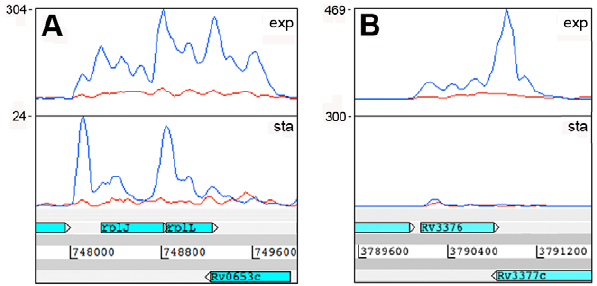
Figure 2. Antisense transcripts arising from 3’ UTRs. Examples of transcription profiles vizualised using the Artemis genome browser. Blue and red traces show transcription in the forward and reverse direction respectively. The x-axis records the position on the genome, and the y-axis records the number of reads mapped at that location; the maximum expression is shown on the y-axis. Examples illustrate 3’ UTR profiles that tail off into the adjacent gene (panel A) or rise to a peak in the overlap region (panel B). A. Rv0653c (a predicted transcriptional regulator) is covered by an antisense transcript extending from the 3’ end of the rplJ - rplL ribosomal protein operon in exponential phase, but not in stationary phase. B. The 3’ end of Rv3377c (a putative cyclase gene) is covered by an antisense transcript from the converging gene Rv3776. Again the antisense overlap is present only in the exponential